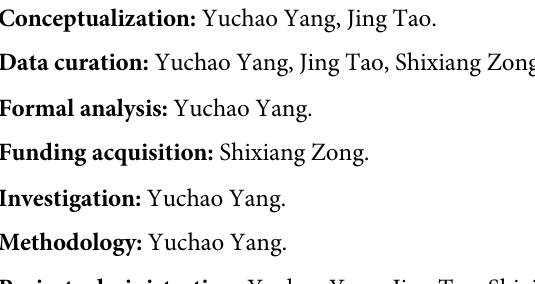
S1 Table. Primers used for RT-qPCR analysis of ACCs and DESs in S . insularis